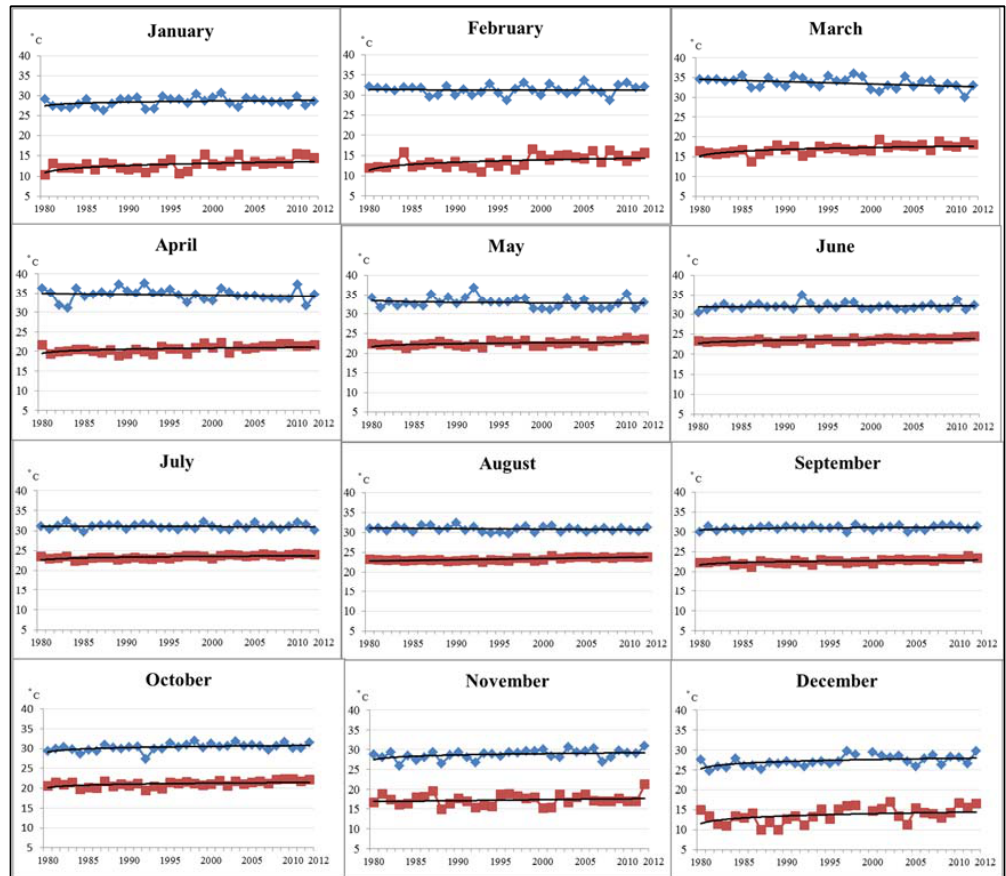
Figure 2. Monthly minimum and maximum temperature recorded at Mae Chan Hill tribe Development station in Chiangrai province.